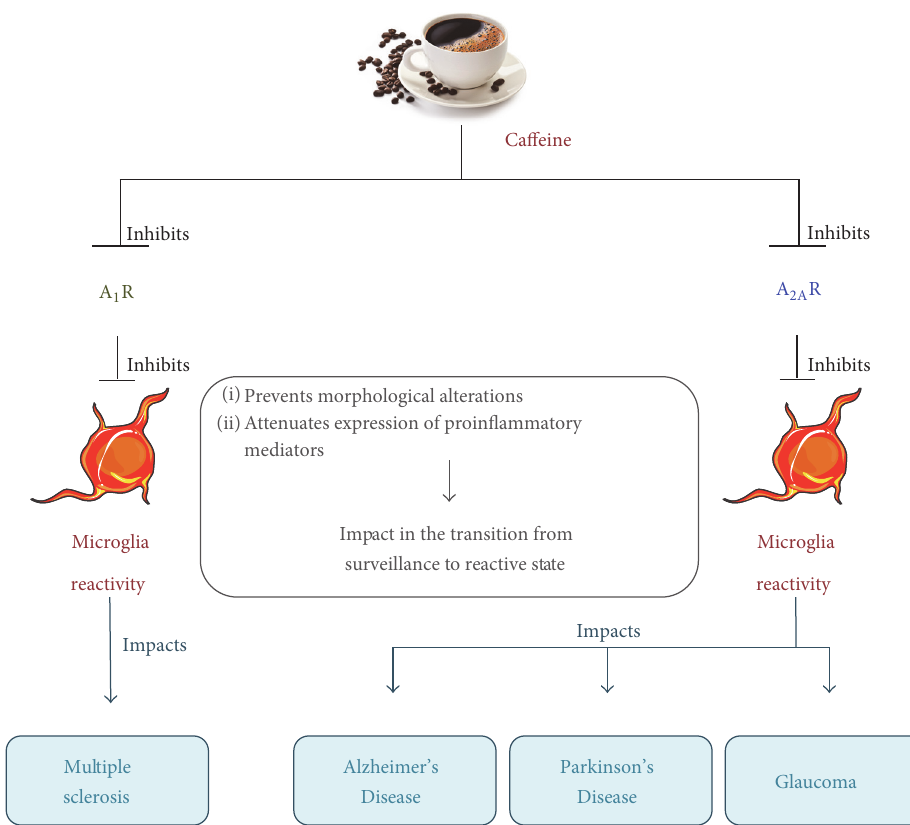
Figure 1: Caffeine reduces microglia-mediated inflammatory environment on CNS degenerative diseases. Schematic summary of the effects of caffeine intake on microglia reactivity and the associated CNS degenerative